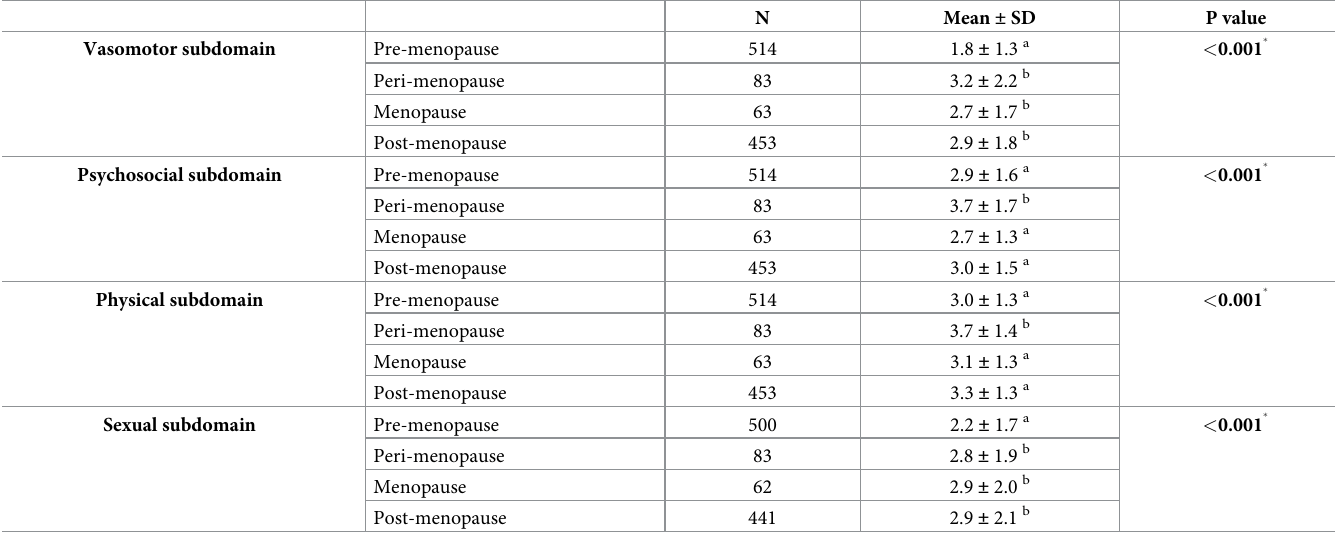
Table 2. Mean scores of MENQOL subdomains according to menopausal